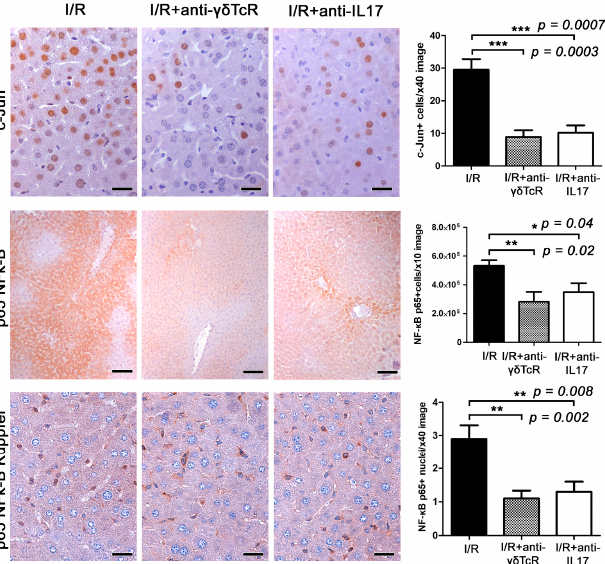
Figure 4. Anti- γδ TcR and anti-IL17a pretreatments downregulate c-Jun and NF- κ B p65 in the liver of mice with I/R-injury. A high number of cells have a nuclear localization of c-jun in affected liver areas. In comparison with I/R controls, c-jun-positive hepatocyte nuclei are significantly reduced in pretreated mice. Likewise, cytoplasmic NF- κ B p65 in hepatocytes is also reduced. In nonparenchymal liver cells comprising mostly Kupffer cells, there is both cytoplasmic expression and nuclear translocation of NF- κ B p65. The latter is significantly reduced in the mice receiving pretreatments. Diaminobenzidine chromogen, haematoxylin counterstain. Scale bars: 25 µ m (c-Jun and NF- κ B p65); 100 µ m (NF- κ B p65 Kupffer). The Y-axis of bar graphs depicts the mean ± SEM of IHC-labelled cells or pixel counts in high-power magnification images. * p < 0.05, ** p < 0.01 and *** p < 0.001.